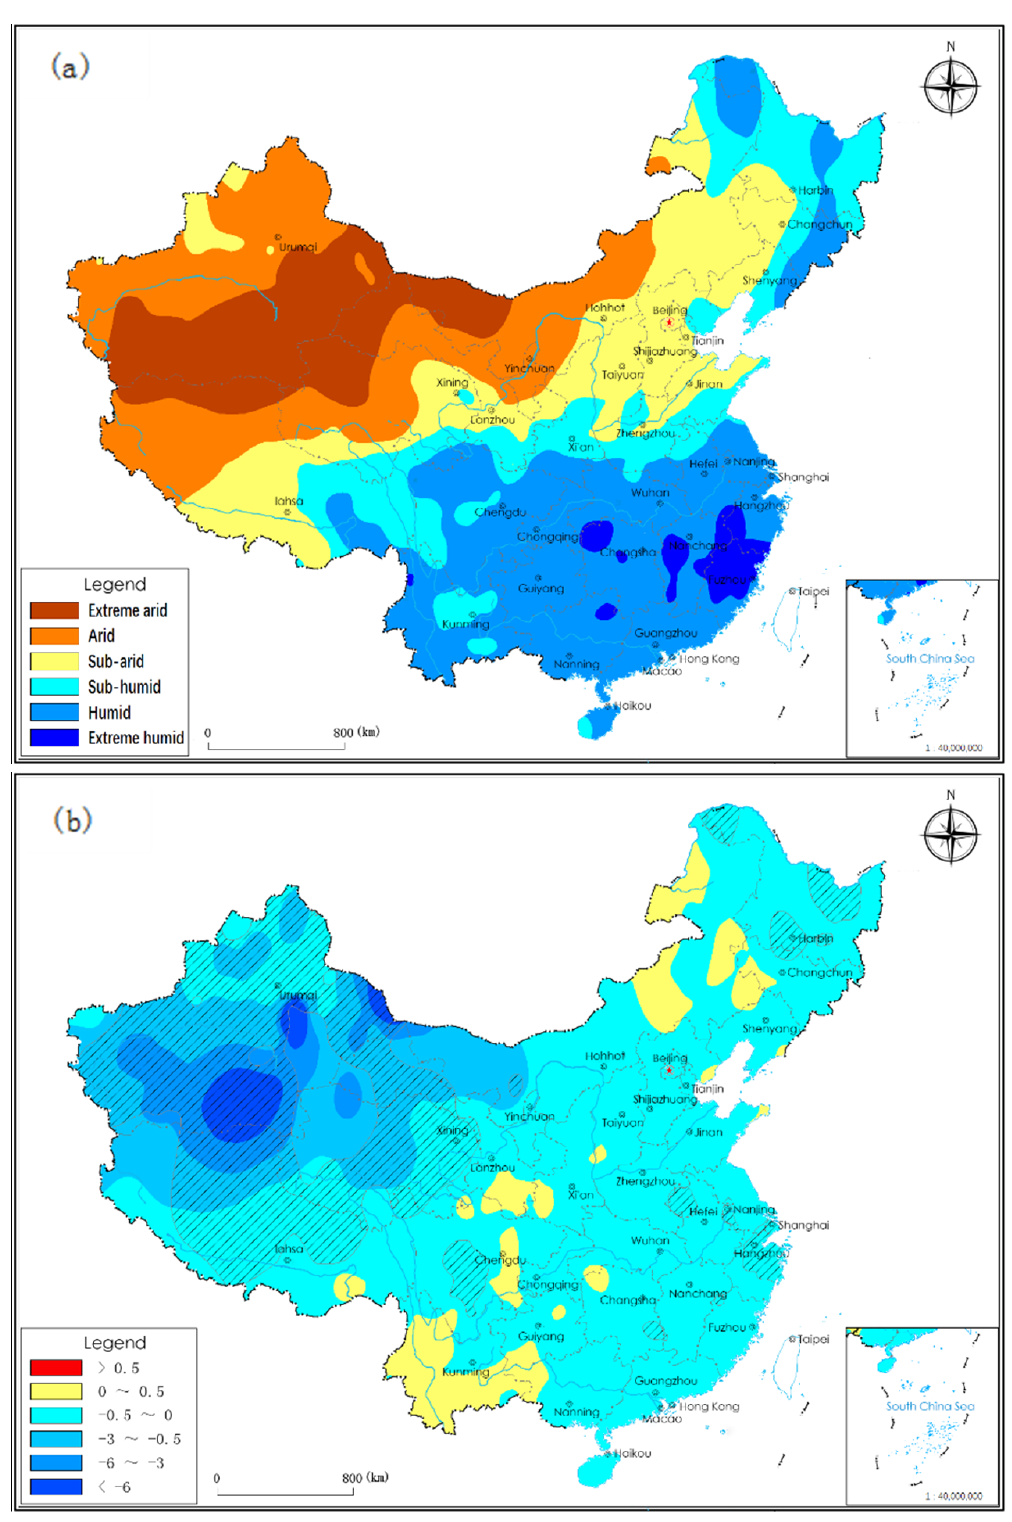
Figure 2. Dry and wet climate zone during 30 years from 1981 to 2010 ( a ); linear trends of the annual aridity index ( b , color filled areas); and the significance test passed the 95% confidence level area ( b , slant line areas) in China from 1961 to 2020.